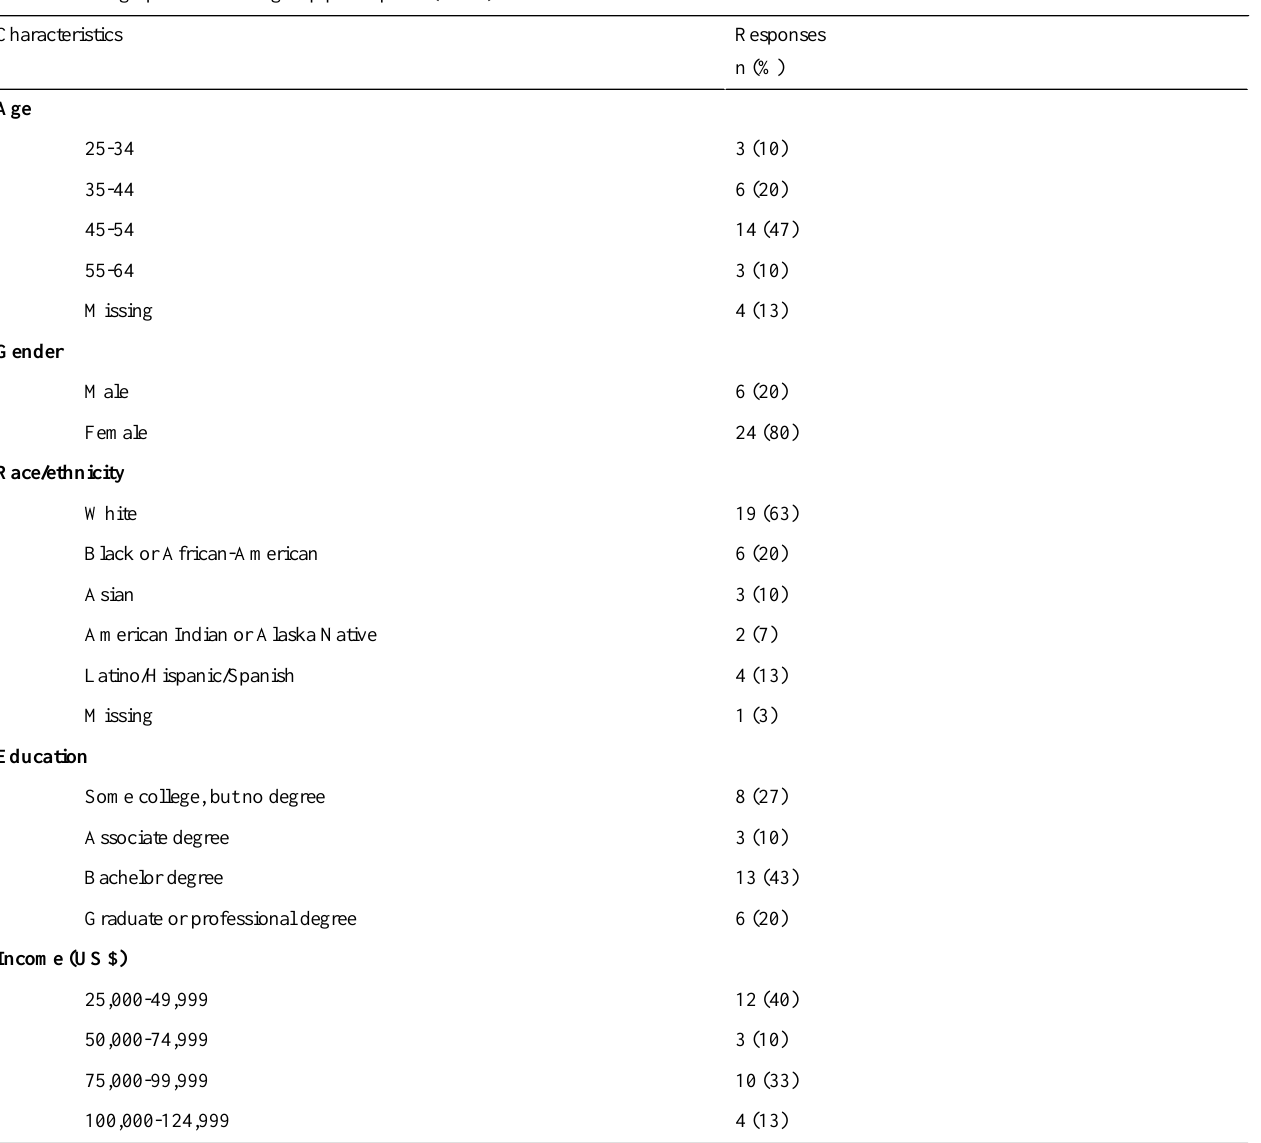
Table 1. Demographics of focus group participants